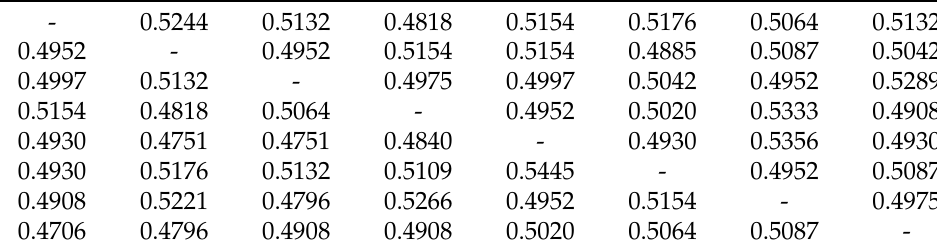
Table 7. BIC-SAC criterion of the proposed